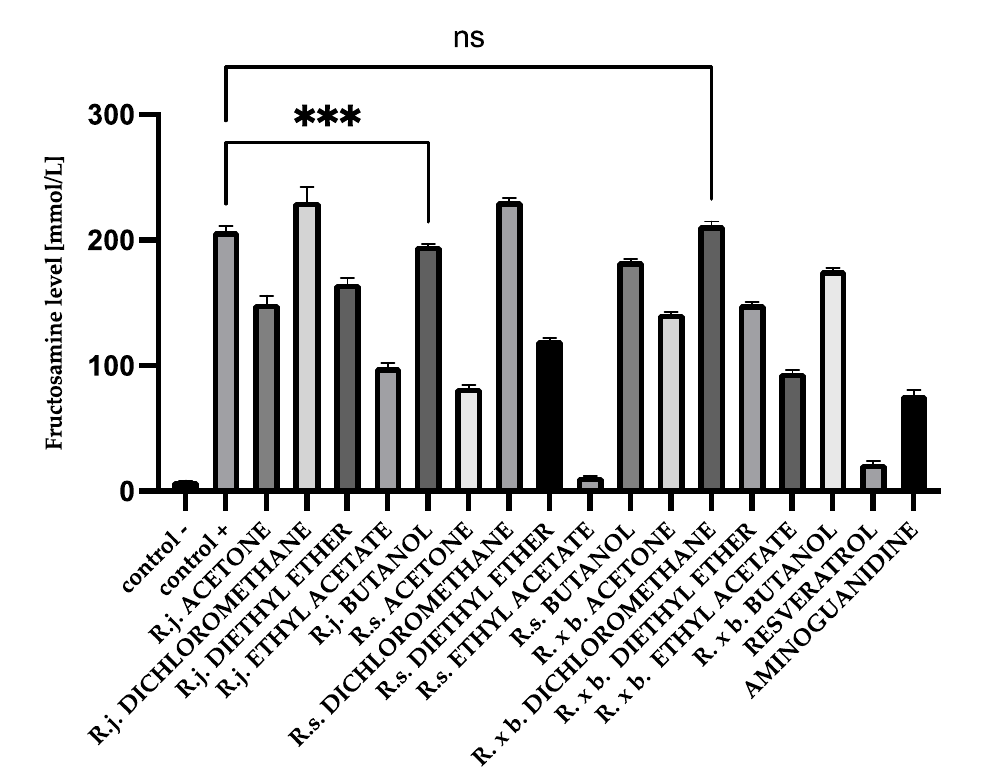
Figure 3. The effect of extracts and fractions on the in vitro formation of fructosamine in HSA glycation. R.j., R.s., and R. × b. mean Reynoutria japonica , Reynoutria sachalinensis , and Reynoutria × bohemica , respectively. Error bars shown in this figure are means ± SD for n ≥ 5. *** Statistically significant at p ≤ 0.001 compared to control +. ns—not statistically significant at p ≤ 0.05. All other results are statistically significant at p ≤ 0.0001 compared to control +. Detailed information can be found in the Supplementary